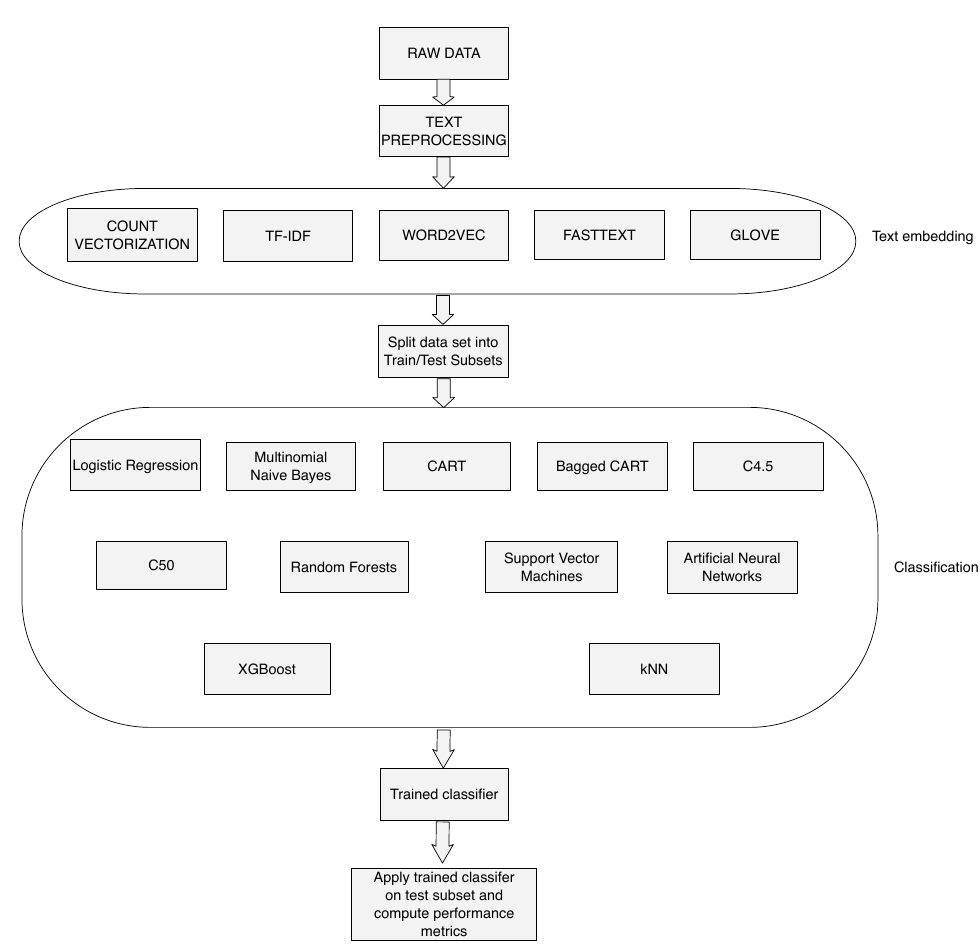
Figure 3. A schematic view classification